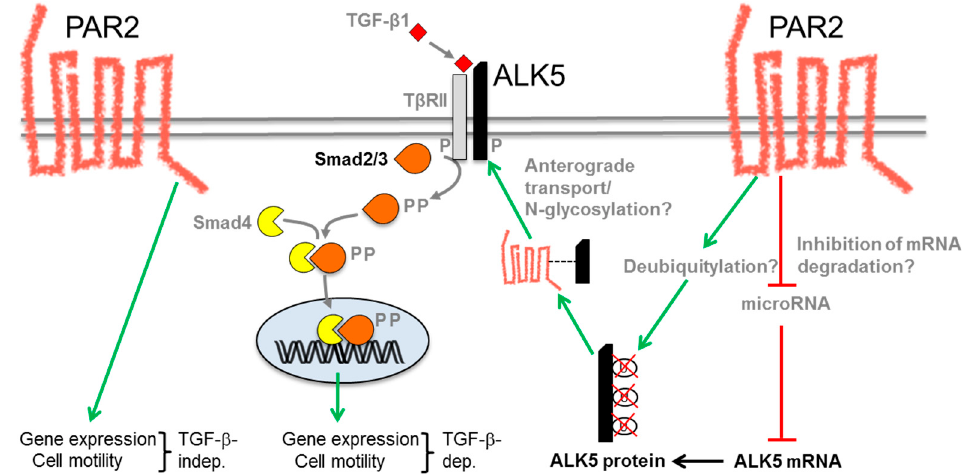
Figure 2. Schematic diagram illustrating the potential mechanisms of the PAR2–TGF- β /ALK5 interaction. On the left-hand side of the figure, the direct, TGF- β -independent (TGF- β -independent) effects of PAR2 on gene expression and cell motility are shown. On the right-hand side, hypothetical mechanisms of PAR2 function are summarized that may result in an increase in ALK5 abundance and/or membrane localization such as inhibition of an ALK5-targeting microRNA, ALK5 deubiquitylation or anterograde transport (plus N -glycosylation) of ALK5 from the Golgi apparatus to the cell surface. An increase in ALK5 expression eventually results in an enhancement of TGF- β -induced Smad2/3C phosphorylation and TGF- β /Smad-dependent (TGF- β -dep.) gene expression and cell motility. Stimulatory interactions are indicated by green arrows and inhibitory interactions by red lines. The physical interaction between intracellular PAR2 and ALK5 is marked by a black stippled line. P, phosphate residue.